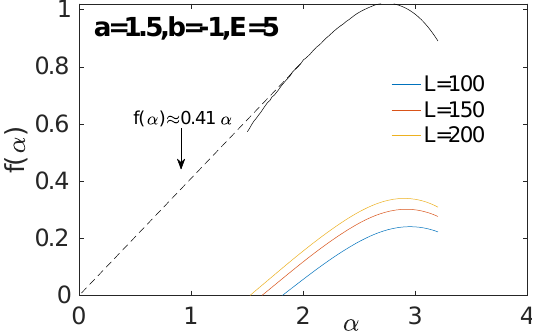
Figure 5: Finite-size extrapolation of the multifractal spectrum f ( α ) for the en- ergy E = 5, disorder strength W = 10, a = 1.5, and β = − 1. f ( α ) is extrapolated from L = 100, 150, and 200 with the corresponding number of disorder realizations 1000, 500, and 100,